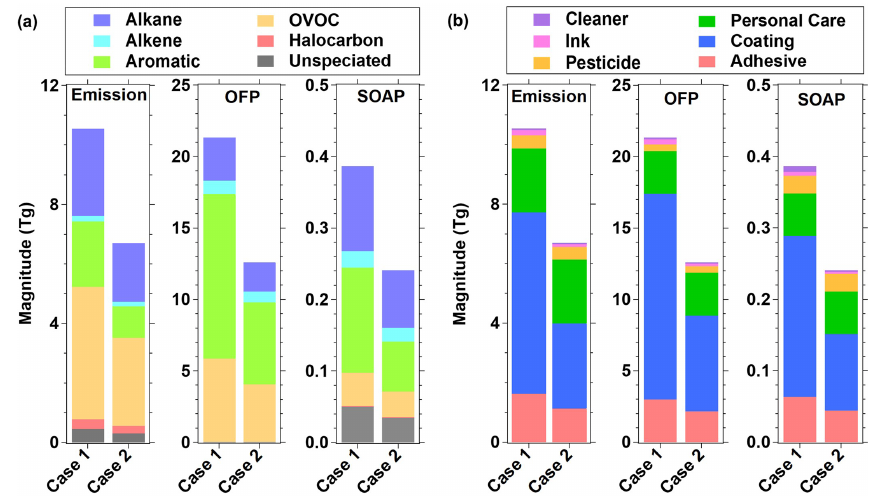
Figure 8. Contributions from (a) different source categories and (b) different NMVOC groups to emissions, OFP, and SOAP. Case 1: emissions in 2017, Case 2: emissions in 2017 after solvent-based products were replaced with water-based